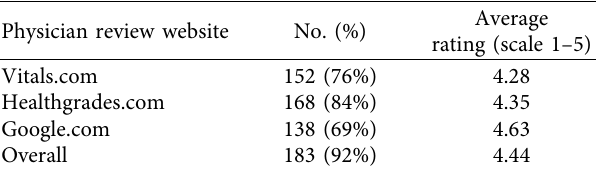
Table 1: Physician rating website, number of oncology surgeons rated per site, and average